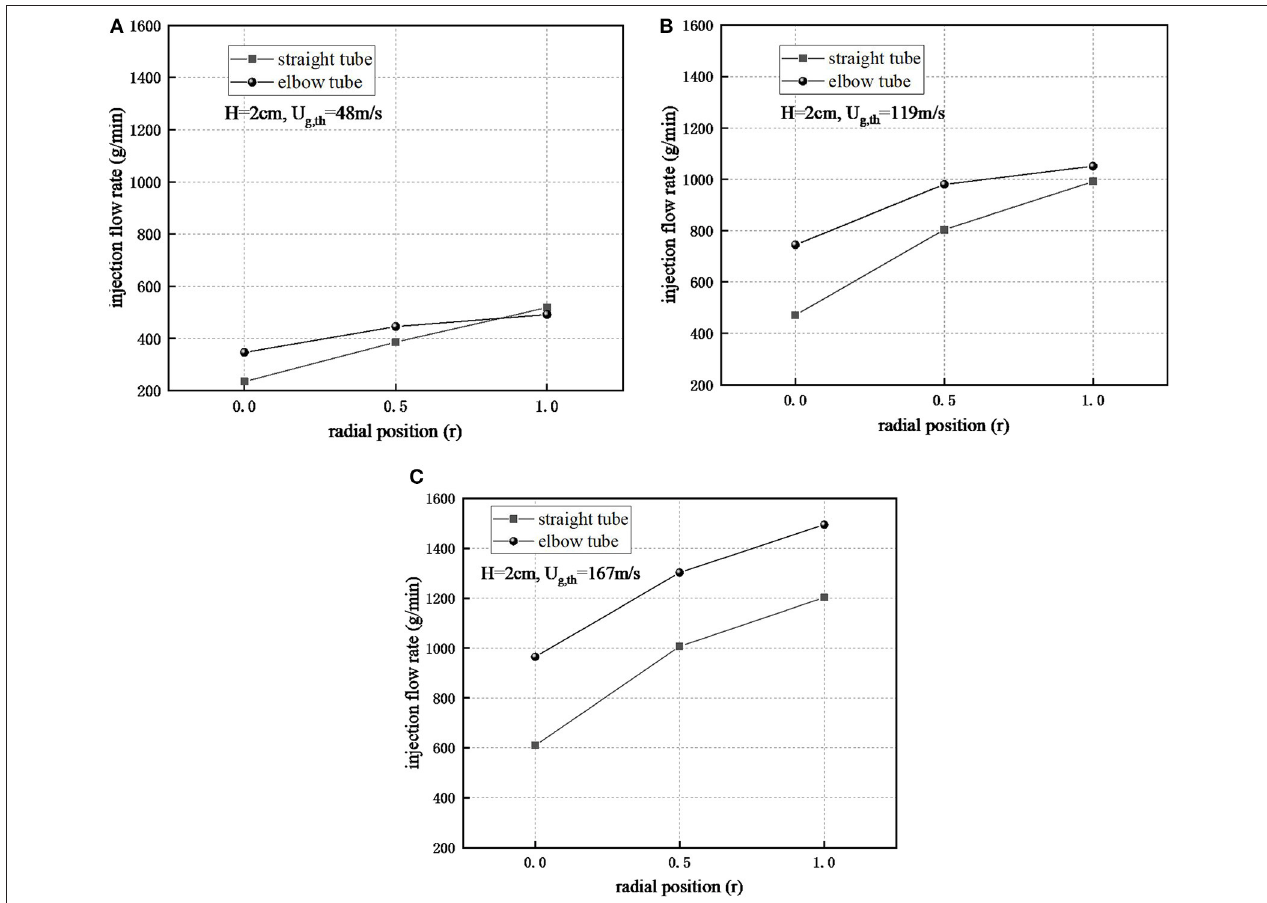
FIGURE 3 | Injection flow rate at submergence depth of 2cm. (A) H = 2cm, U g,th = 48 m/s, (B) H = 2cm, U g,th = 119 m/s, (C) H = 2cm, U g,th = 167